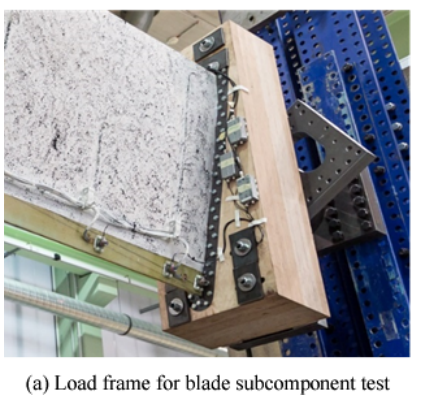
Figure 2. Solutions for mounting blade tip segment to the test stand.